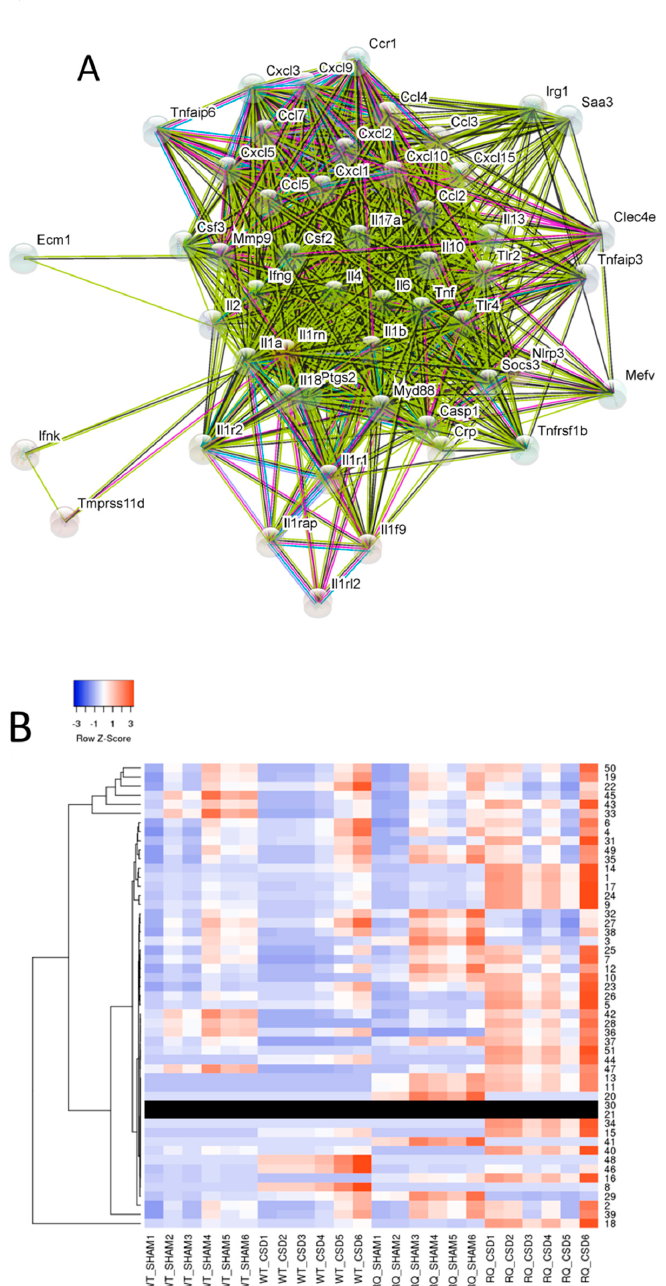
Figure 2. IL-1RN functionally-related genes. ( A ) Gene network of the IL-1RN functionally related genes. The edges connecting the nodes represent the interactions between genes, in terms of co-expression (black), text mining (light green), protein homology (cyan), association in curated database (light blue), and high-throughput experiments (purple). Empty nodes represent proteins of uncharacterized 3D structure, while filled nodes represent proteins with known or predicted tertiary structure. ( B ) Expression heatmap for the top correlated genes to IL-1RN , as determined in the GSE67933 dataset. Average linkage was used as clustering method and Euclidean distance as distance measurement. Tree branches represent the distance between